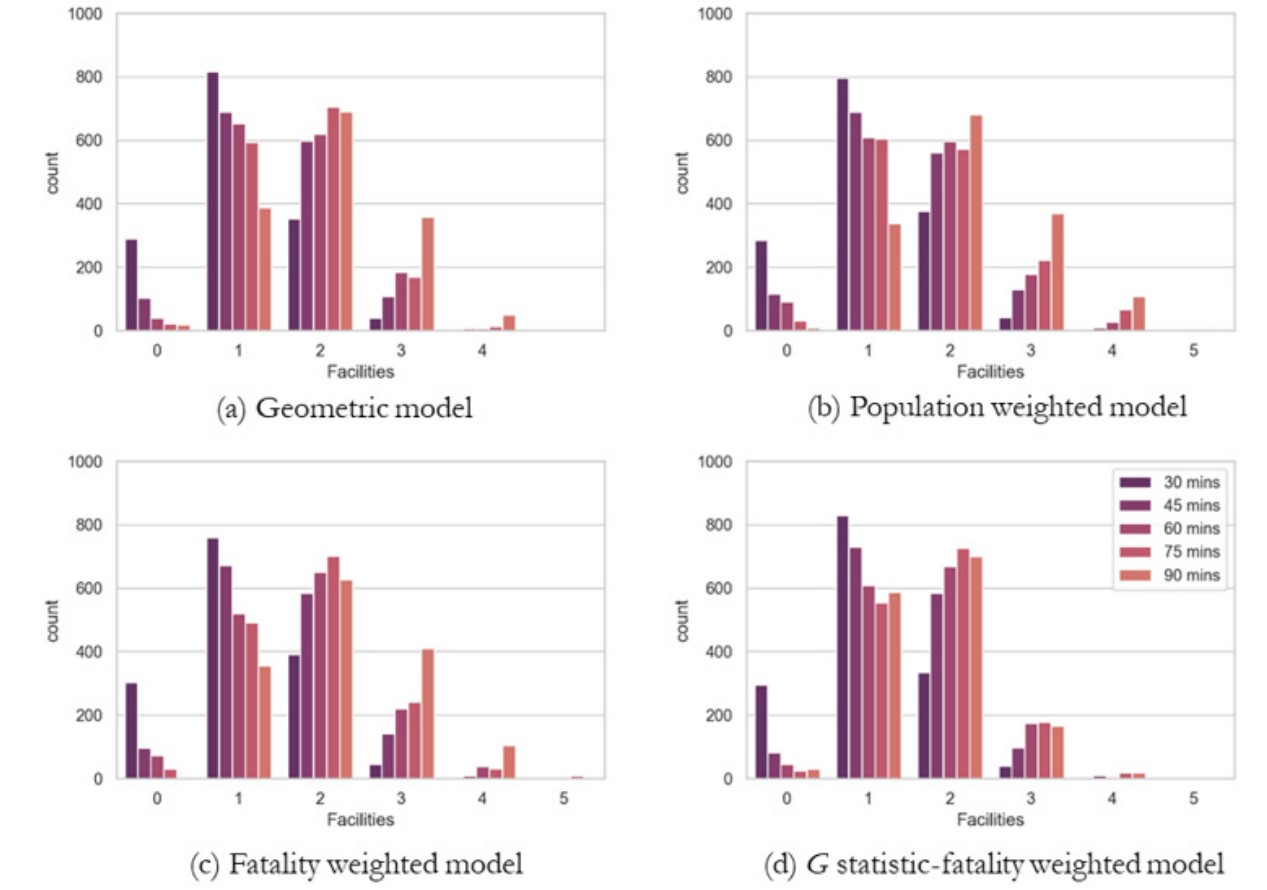
Figure 9. Number of facilities available from each demand by different TraCt models. ( a ) Geometric model; ( b ) Population weighted model; ( c ) Fatality weighted model; ( d ) G statistic-fatality weighted model.